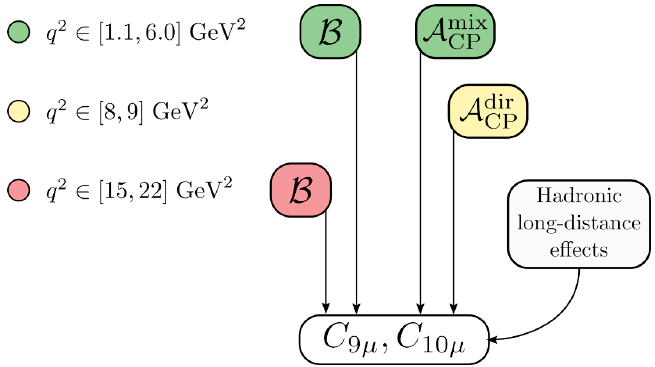
Figure 9 . Illustration of the strategy to determine complex Wilson coefficients C 9 µ and C 10 µ using the four observables and input on the long-distance